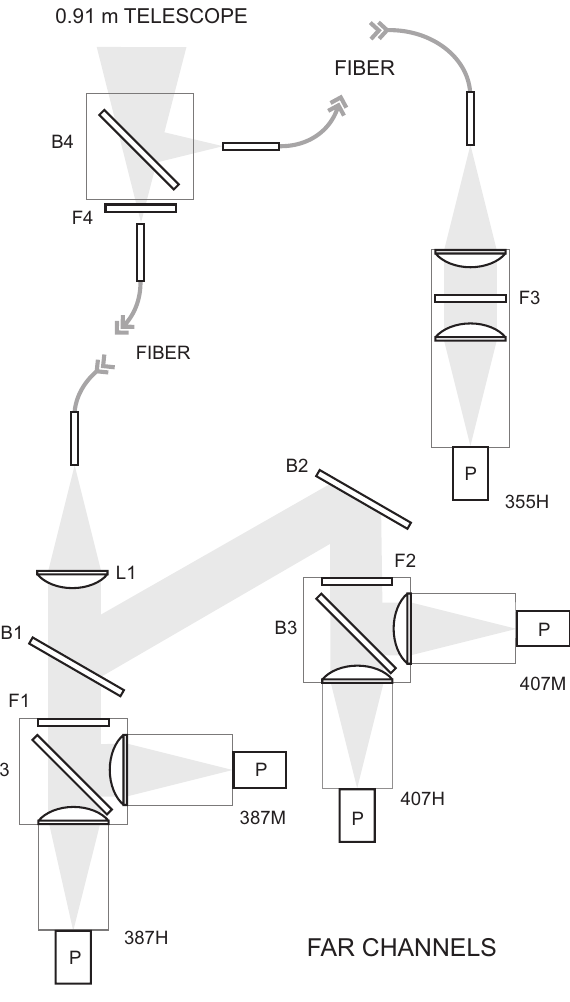
Fig. 9. TMW lidar receiver second configuration (2007–2009) for the high- and mid-intensity